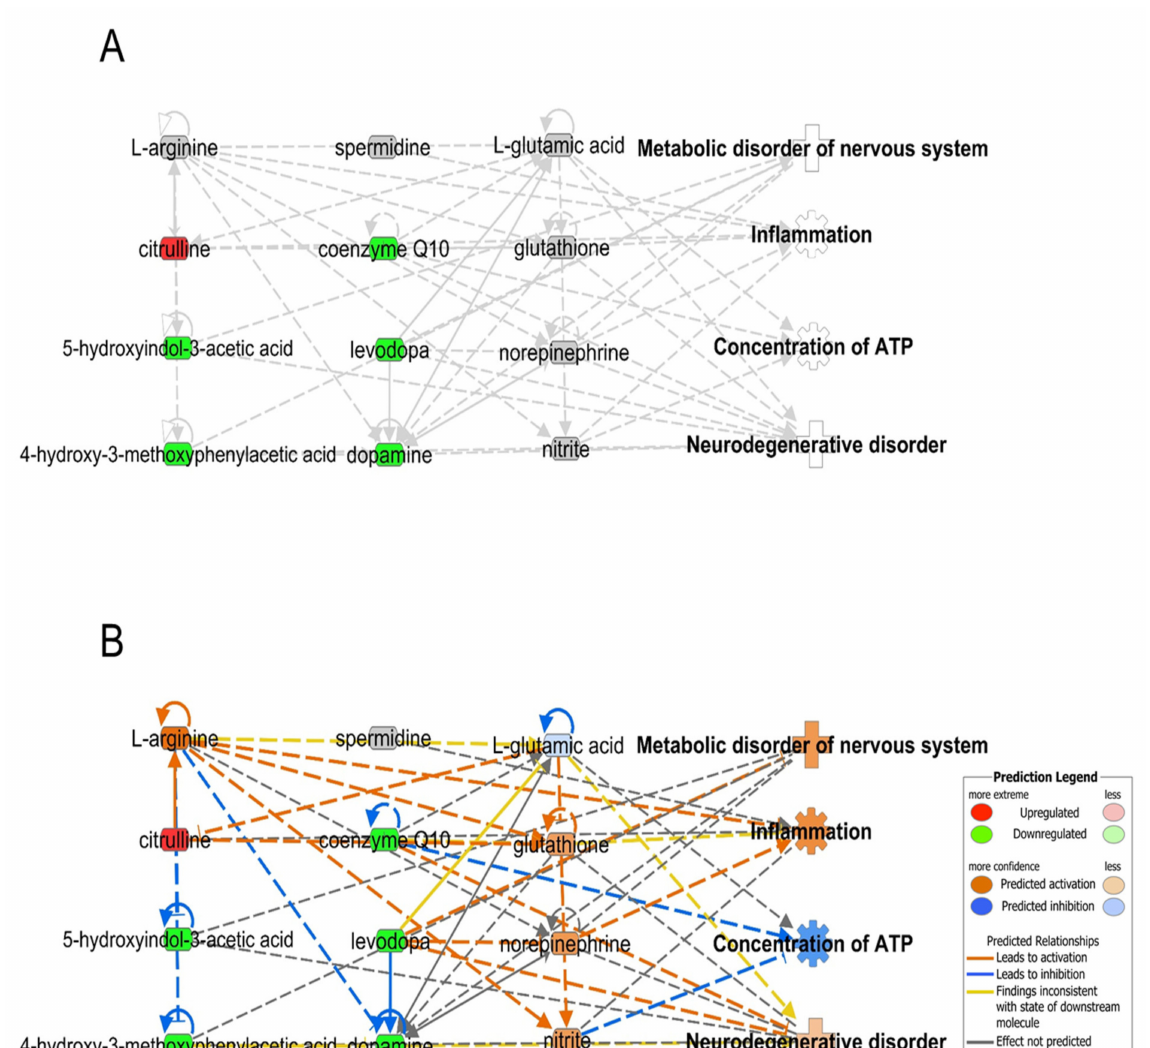
Figure 2. Functional analysis of the metabolomic network of cerebrospinal fluid from multiple system atrophy patients using the ingenuity pathway analysis (IPA) program. Non-predicted metabolomic network ( A ) and predicted metabolomic network ( B ). Red and green areas indicate upregulated and downregulated metabolites, respectively. Orange and blue areas indicate activation and suppression by IPA prediction, respectively. Prediction legends are provided from IPA (http://www.ingenuity. com, accessed on 16 January